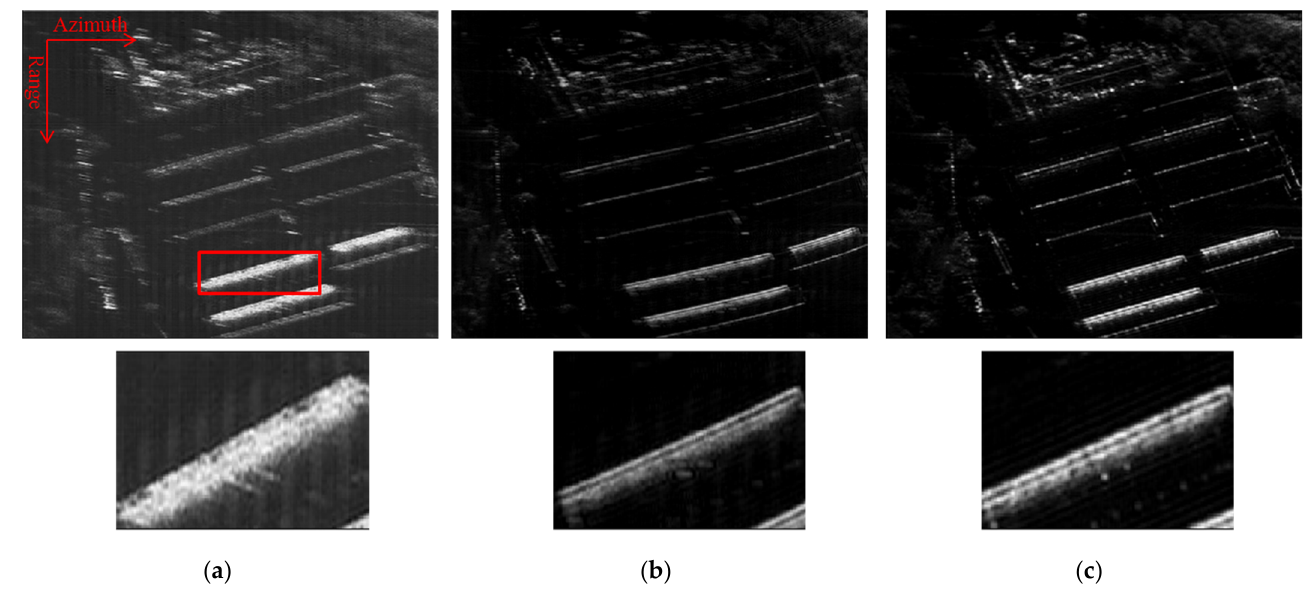
Figure 9. Imaging results of scene B using different methods. ( a ) PGA; ( b ) method in [20]; ( c ) proposed method.